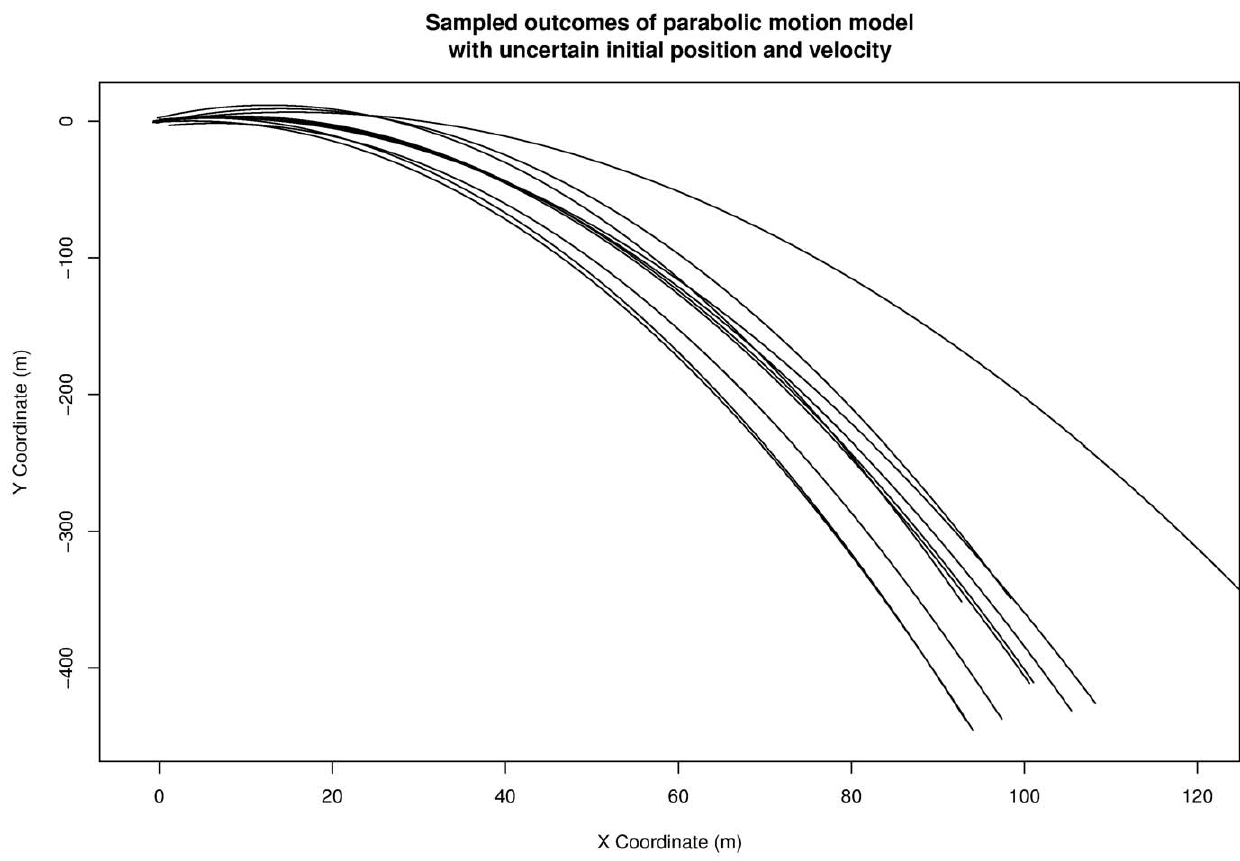
Figure 2. The path of the object in the example model is plotted for ten runs of the model. The path depends on the uncertain parameters. Generated using Model S1.